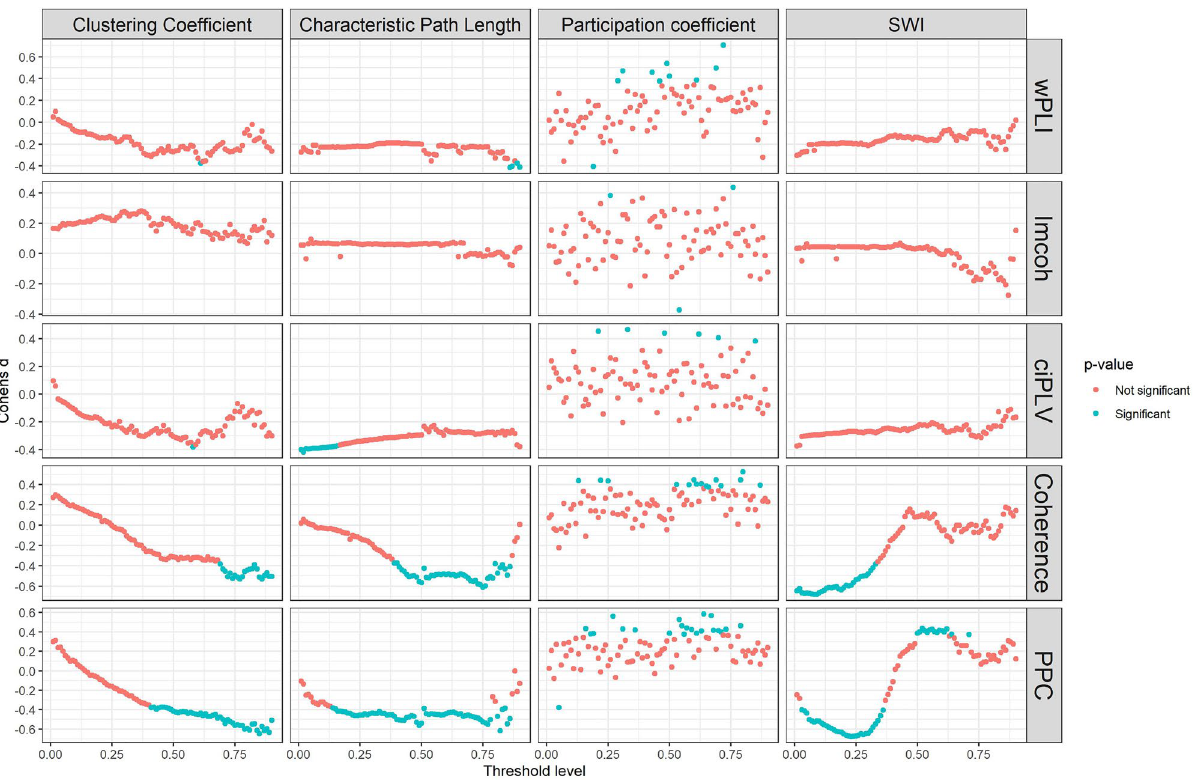
Figure 9. The Cohen’s d of the gender comparison on the different thresholds in sensor space. A permutation t-test was used to estimate the differences between the two groups. The blue dots represents the effect as significant (p-value < 0.05), the red represents the non-significant effect (p-value > 0.05). ggplot2 3.3.6 (https:// ggplo t2. tidyv erse. org/) was used to create this